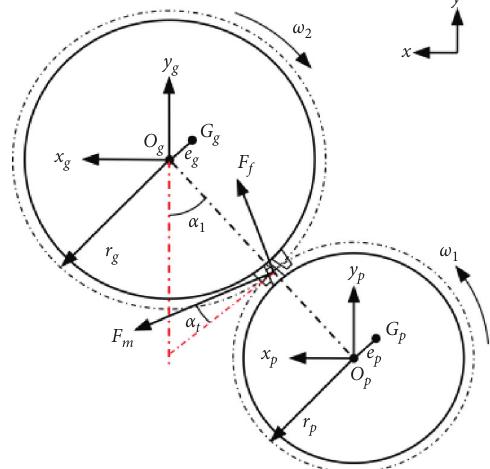
Figure 3: Forces and displacements within the gear